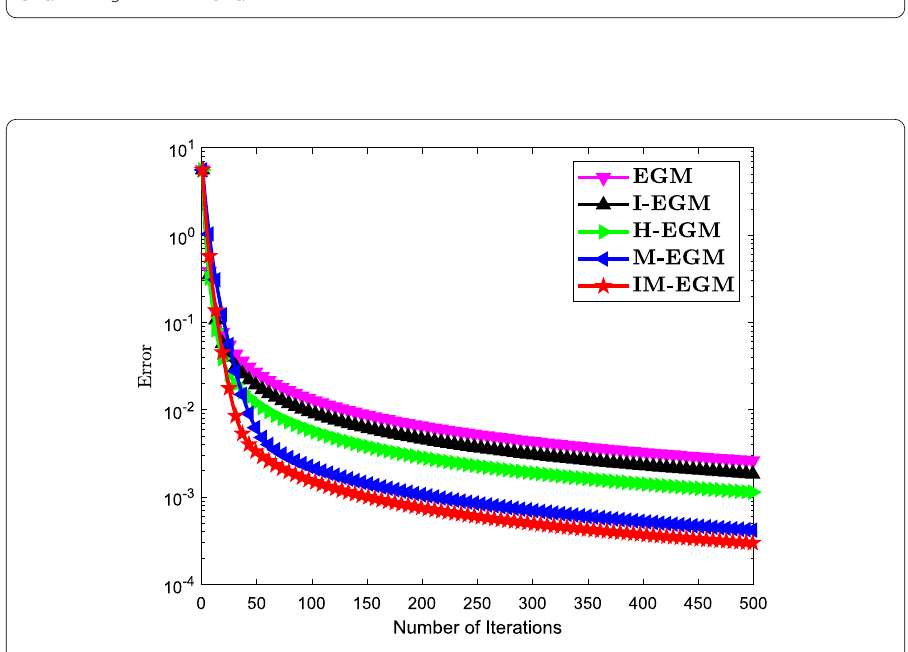
Figure 5 Numerical comparison of Algorithm 1 and Algorithm 2 using Algorithm 1 in [52], Algorithm 2 in [51], and Algorithm 1 in [18], while N = 30 for the first 500 iterations